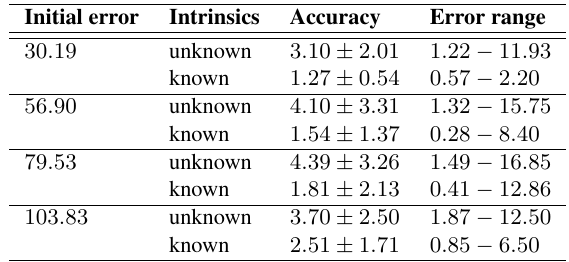
Figure 4. (a) Example images of our dataset. The point cloud generated from the images can be seen in (b).(c) Resulting mesh model.